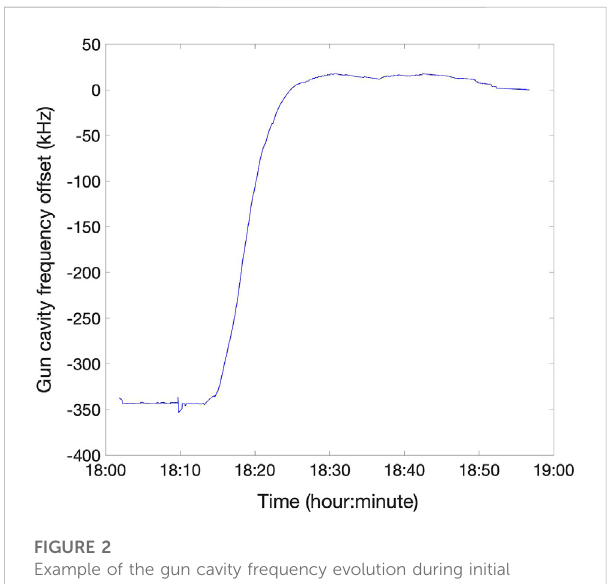
FIGURE 2 Example of the gun cavity frequency evolution during initial turn-on.